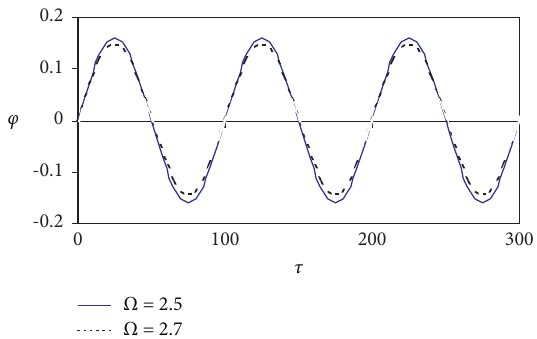
Figure 6: The analytical solutions for case (ii) in Section 4.1.